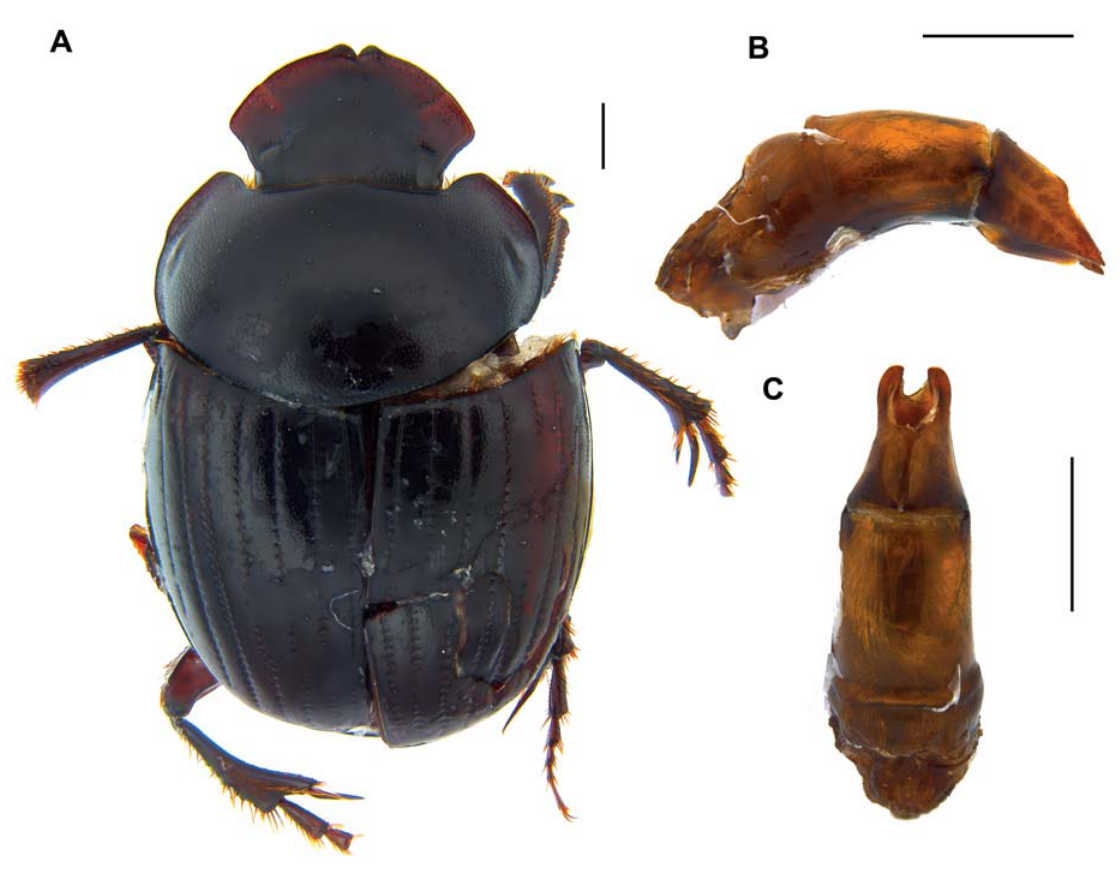
Fig. 4. Canthidium ayri sp. nov., holotype (CEMT) A . Dorsal view. B . Lateral view of aedeagus. C . Dorsal view of aedeagus. Scale bars: 1